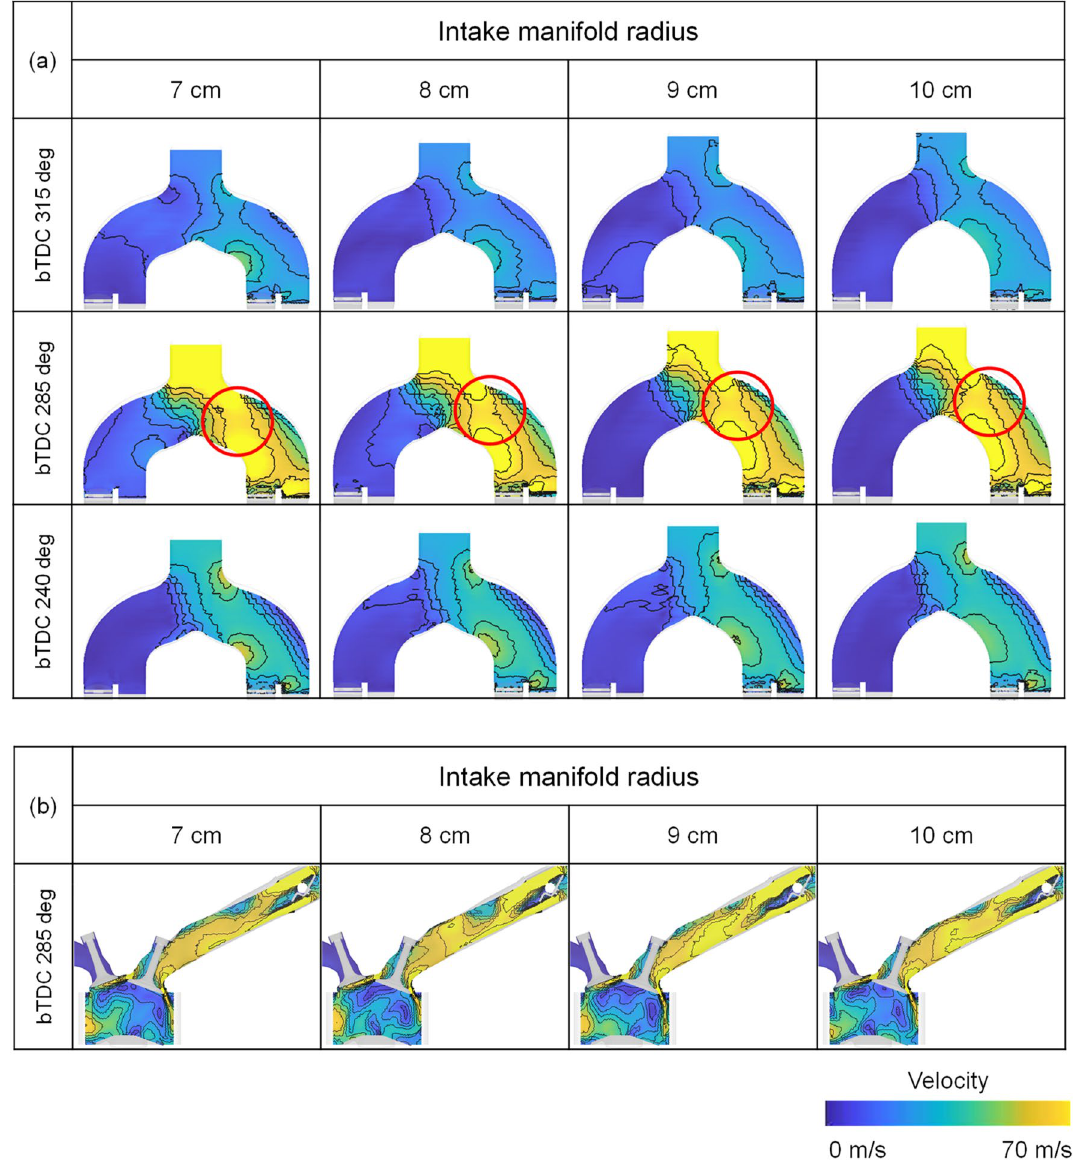
Figure 23. Velocity distribution in ( a ) intake manifold and ( b ) valve plane 1 for different intake manifold curve radius at engine speed of 3000